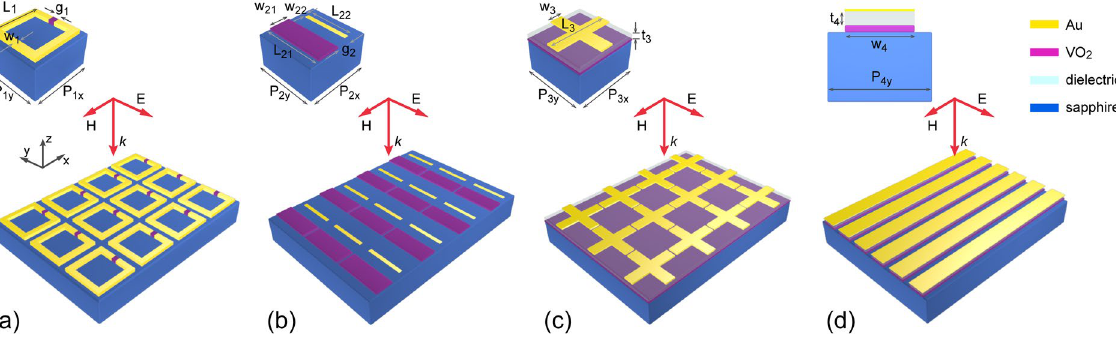
Figure 1. Vanadium dioxide enables hybrid THz metamaterials. Schematic showing four different metamaterial examples, each consisting of an array of hybrid resonators. These metamaterial designs include ( a ) gap-loaded split ring resonators (SRRs), ( b ) asymmetric VO 2 /Au double-bars, ( c ) Au-cross/VO 2 absorber structures, and ( d ) Au/VO 2 paired-strips. The geometrical parameters (all unit in μ m) are: P 1x = P 1y = 30, L 1 = 25, w 1 = 3 and g 1 = 1.5; P 2x = 75, P 2y = 72, L 21 = 70, L 22 = 55, w 21 = 25, w 22 = 5, and g 2 = 20; P 3x = P 3y = 100, L 3 = 95, w 3 = 20 and t 3 = 8; P 4y = 90, w 4 = 60 and t 4 = 12. The thickness of VO 2 in ( a ) is 200 nm and that in ( b ), ( d ) and ( d ) is 3 μ m. The thickness of gold in all designs is 200